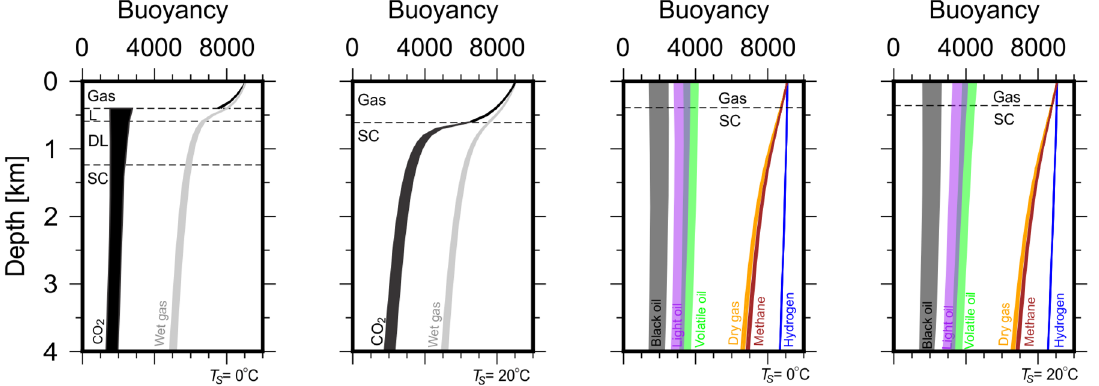
Figure 4. Fluid buoyancy calculated for other hydrocarbon and non-hydrocarbon fluids listed on Table 1 calculated using PR78, SRK and RK EoS for dry/wet gas and hydrogen and using appropriate EoS for hydrocarbon fluids 12–19 . Wet gas exhibits similar properties to CO 2 at T s = 20 ◦ C, whilst dry gas exhibits similar properties to methane. Hydrocarbon fluid buoyancies are significantly lower than dry gas and methane and decrease with molecular weight. Hydrogen buoyancy varies little with depth.